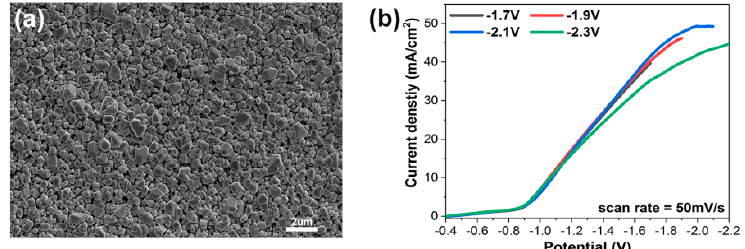
Figure 2. Characterization of electrodeposited copper thin film electrode. ( a ) SEM image of electrodeposited Cu on NiTi substrate in a solutioin of 0.25 M CuSO 4 and 50 mM H 2 SO 4 . ( b ) Linear sweep voltammogrames of different ending potentials working electrodes in CO 2 -saturated 0.1 M KHCO 3 .